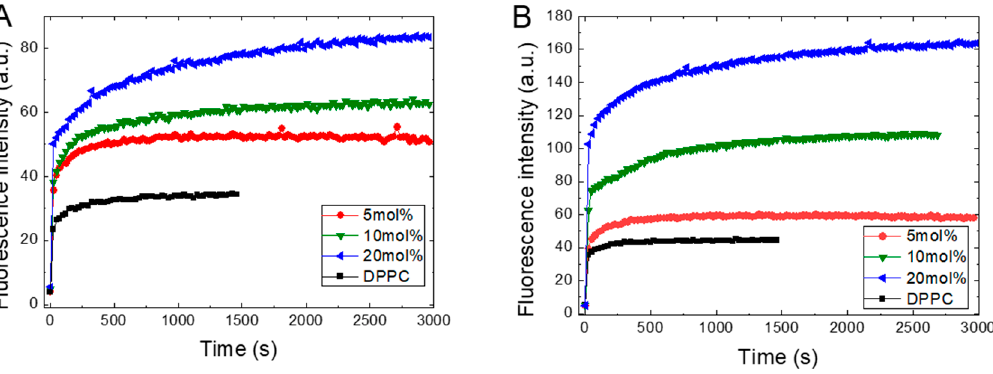
Figure 2. Kinetics of ANS’s (16 µ M) inclusion into the DPPC (0.8 mg / mL) membrane at 25 ◦ C in the presence of TS ( A ) or Toc ( B ). TS and Toc concentrations are given in the legend.